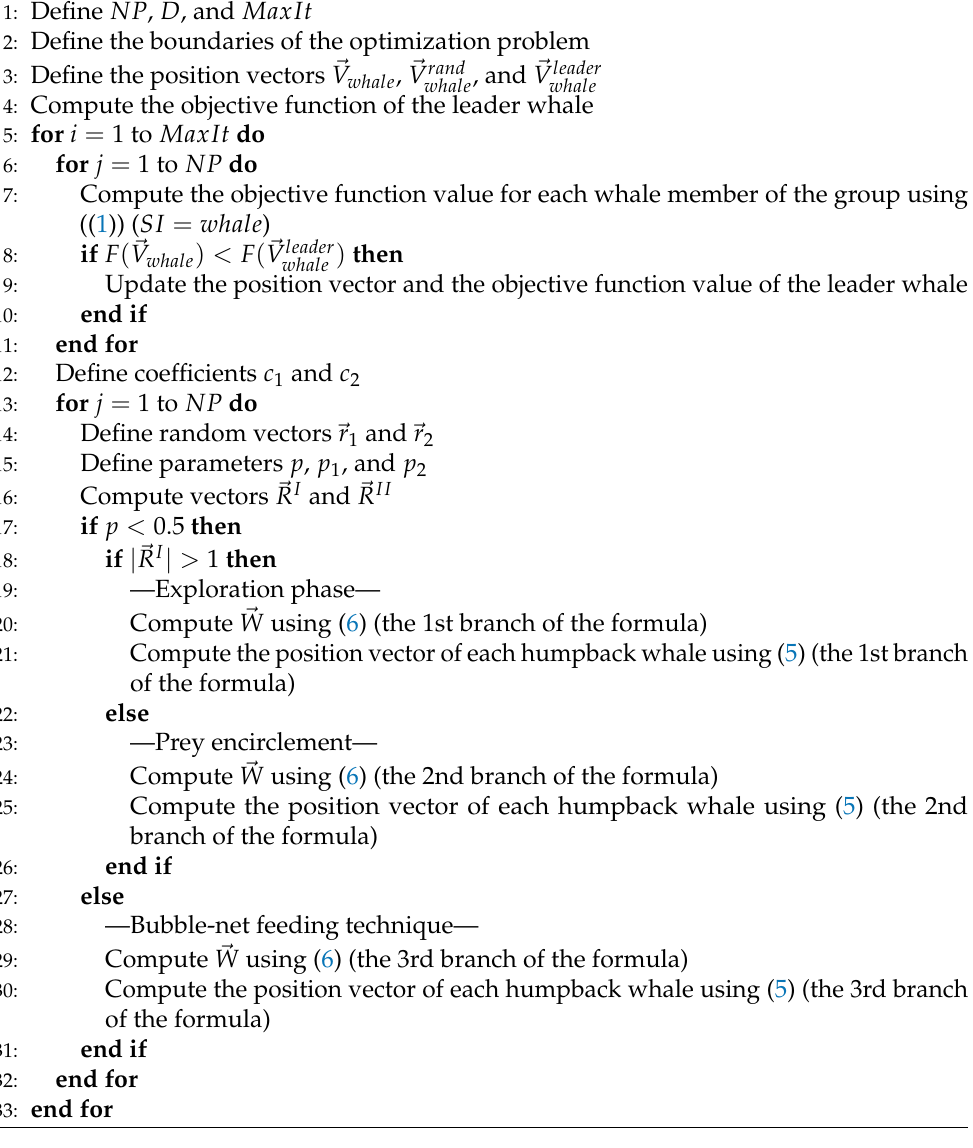
Algorithm A2 Pseudo-code of the Whale Optimization